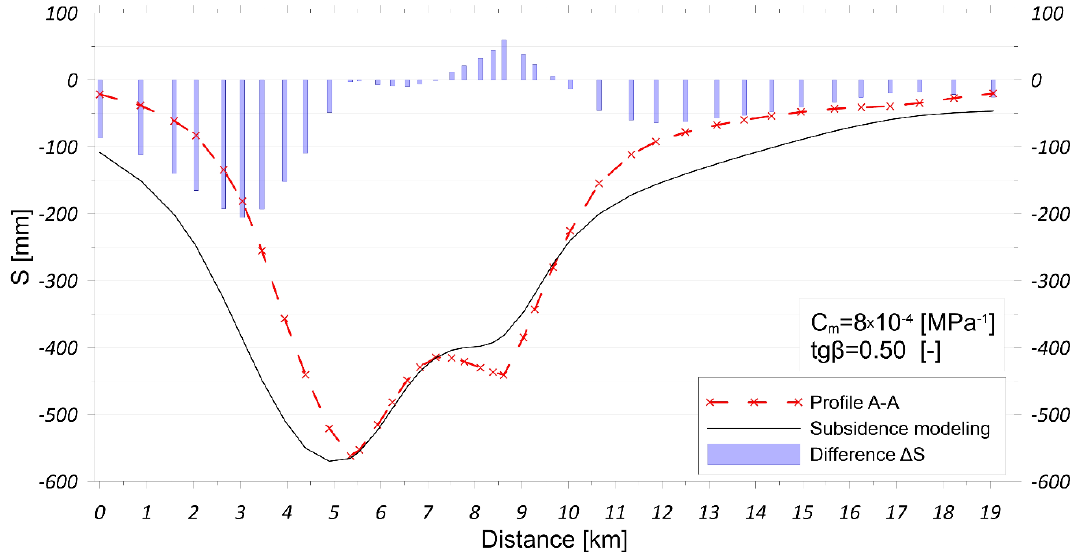
Figure 7. Fitting the model to the A-A dewatering trough profile with a plot of differences.